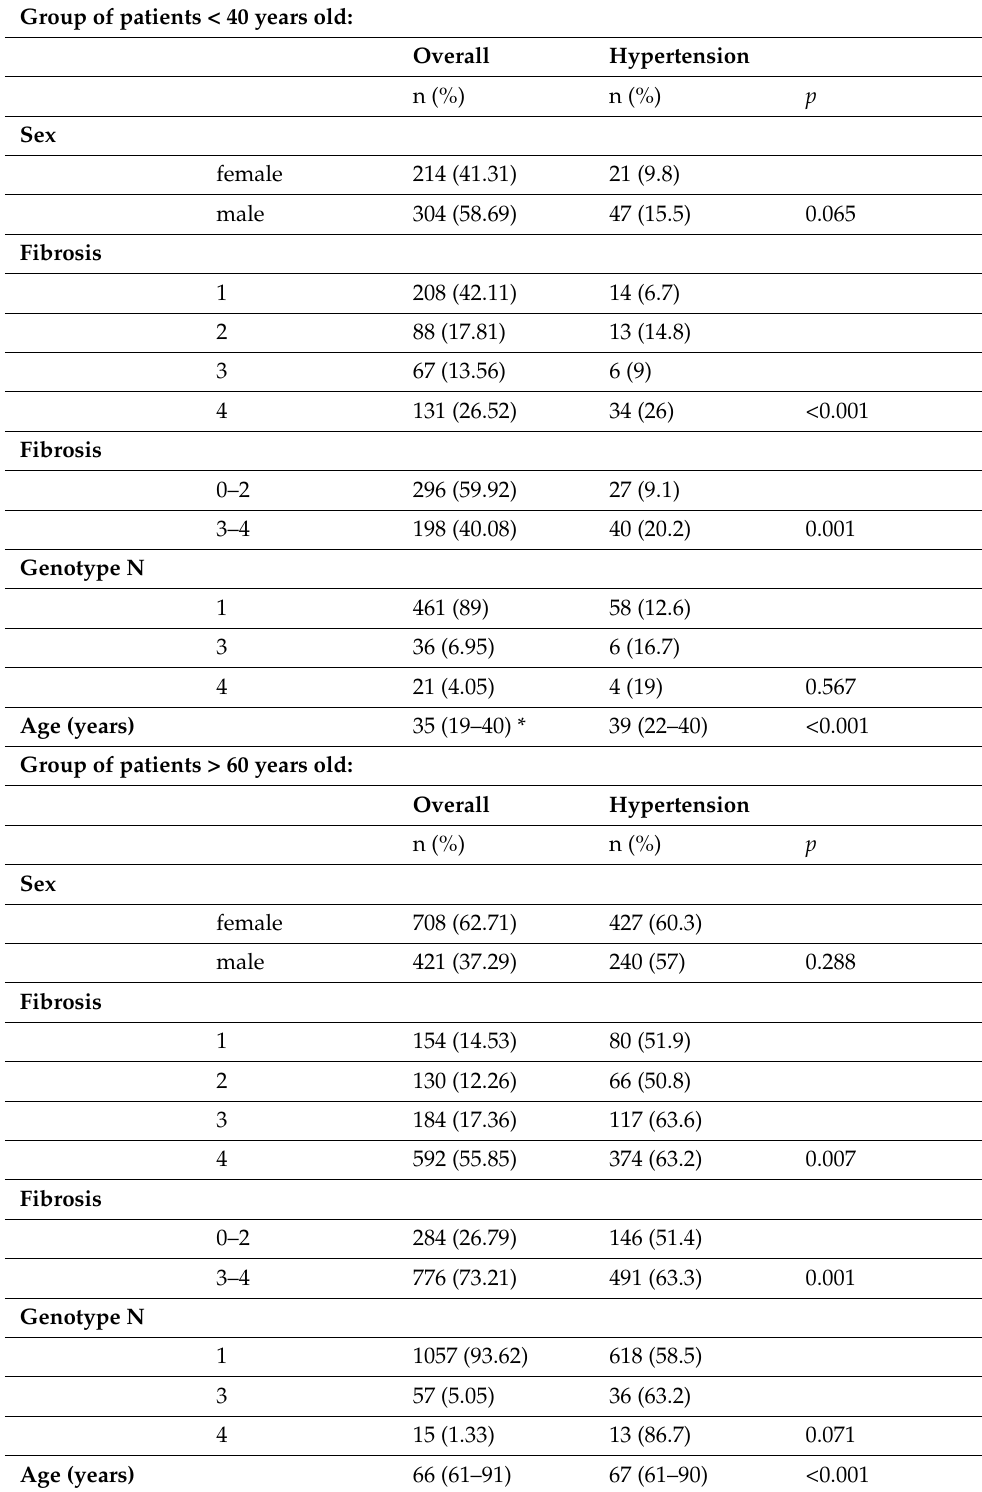
Table 6. The analysis of the incidence of hypertension. Group of patients < 40 years